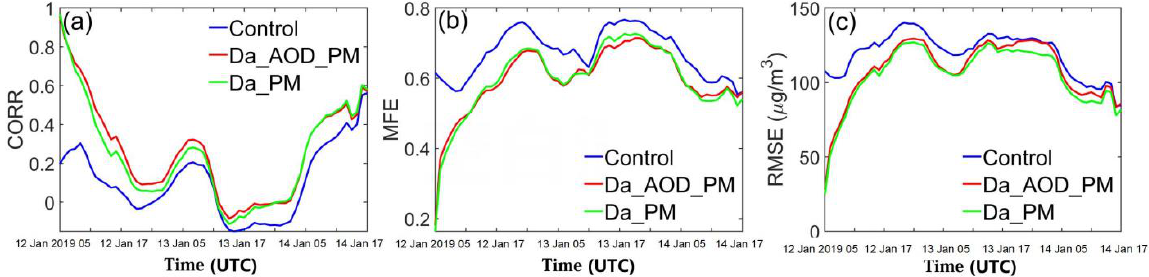
Figure 7. Time series of CORR ( a ), MFE ( b ), and RMSE ( c ) for PM 2.5 model forecasts of the control (blue line), Da_AOD_PM (red line), and Da_PM (blue